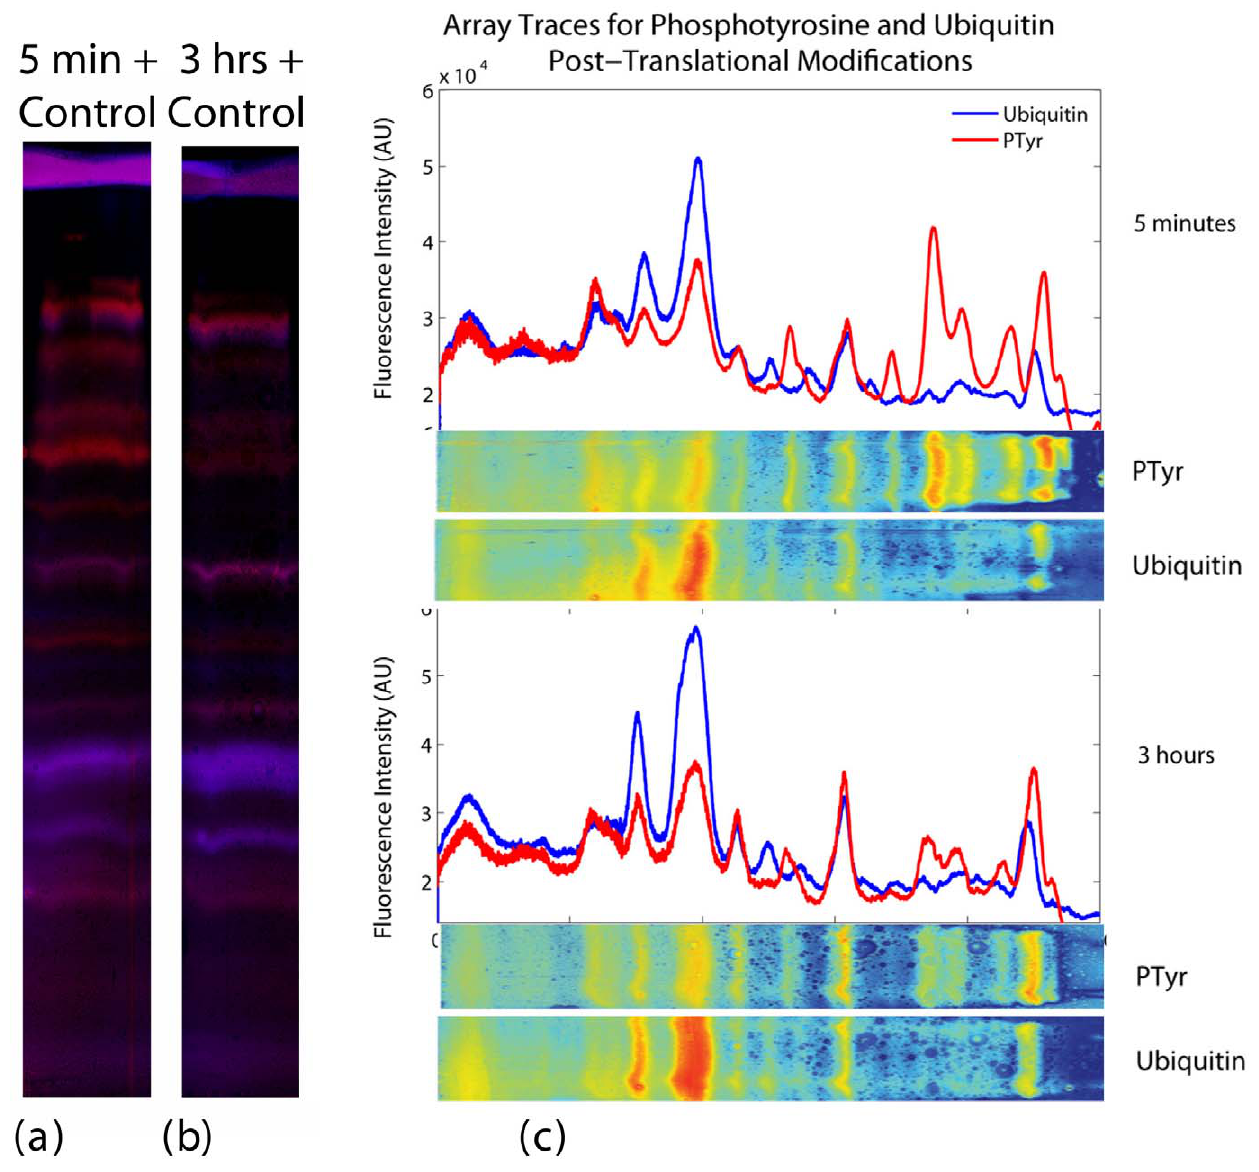
Figure 3. Identifying Protein-Protein Interactions. (a) Immunoprecipitates of phosphorylated proteins from T-47D (Manassas, VA) lines grown in media, treated with Heregulin for 5 minutes, and 3 hours, and control, in media without Heregulin, are mixed together, run on an SDS-PAGE gel and transferred overnight. The slides are probed with anti-ubiquitin (blue) and anti-phosphotyrosine (red). (b) The experiment is repeated, with cells treated with Heregulin for 3 hours. (c) The images from (a) and (b) are separated by color channel, thresholded, and filtered. (PTyr=anti- Phosphotyrosine, Ub=anti-Ubiquitin). The images are horizontally averaged across the gel lane, and plotted as a function of position. Clear differences between the phosphorylated states can be seen. The PTyr and Ub traces are markedly different, indicating that a distinct subset of phosphorylated proteins are ubiquitinylated. Since each lane is mixed with an equal quantity of control lysate, the differences shown here are solely due to the changes in phosphorylation from 5 minutes to 3 hours of treatment with Heregulin. Additionally, the ubiquitin traces can be seen to clearly overlap selected phosphorylation peaks, indicating proteins that have dual post-translational modifications.